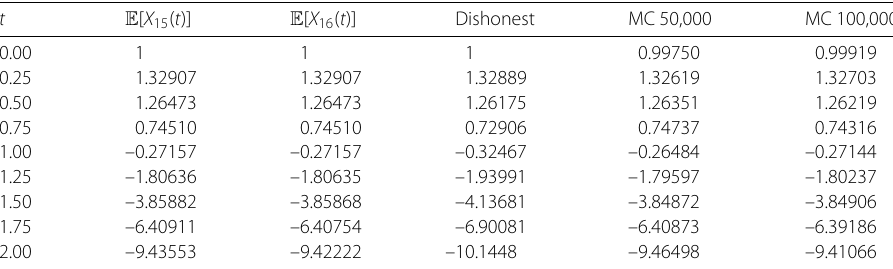
Table 7 Approximation of the expectation of the solution stochastic process. Example 4.2